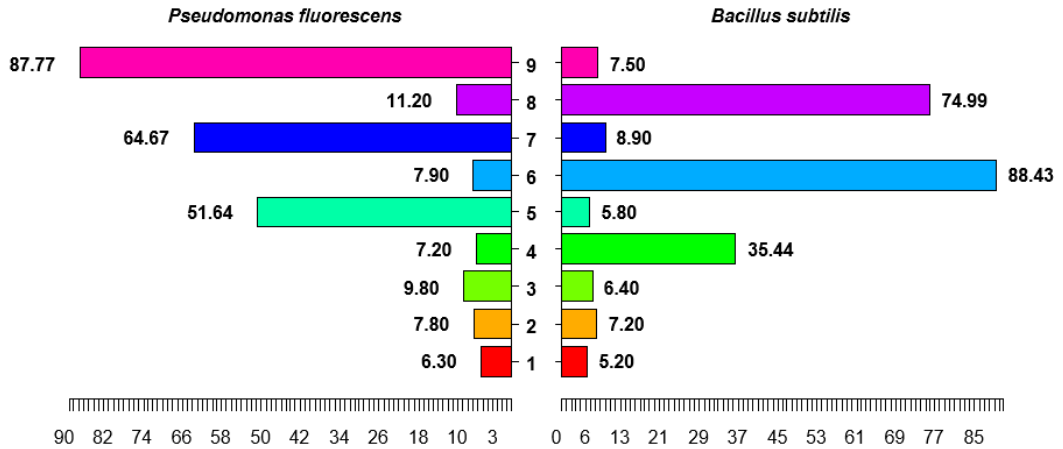
Figure 3. The count of endophytic bacteria colonising the white lupine roots—measurement with the FISH method (fluorescence in situ hybridisation) (10 7 × 0.5 g − 1 fresh weight of the root). Explanation: 1. Uninoculated plant (control variant); 2. Plant inoculated with Bradyrhizobium sp. bacteria (isolated from the Nitragina preparation); 3. Plant inoculated with Bradyrhizobium sp. bacteria (isolated from the Nitroflora preparation); 4. Plant inoculated with Bacillus subtilis bacteria; 5. Plant inoculated with Pseudomonas fluorescens bacteria; 6. Plant coinoculated with Bradyrhizobium sp. (isolated from the Nitragina preparation) and Bacillus subtilis bacteria; 7. Plant coinoculated with Bradyrhizobium sp. (isolated from the Nitragina preparation) and Pseudomonas fluorescens bacteria; 8. Plant coinoculated with Bradyrhizobium sp. (isolated from the Nitroflora preparation) and Bacillus subtilis bacteria; 9. Plant coinoculated with Bradyrhizobium sp. (isolated from the Nitroflora preparation) and Pseudomonas fluorescens bacteria.